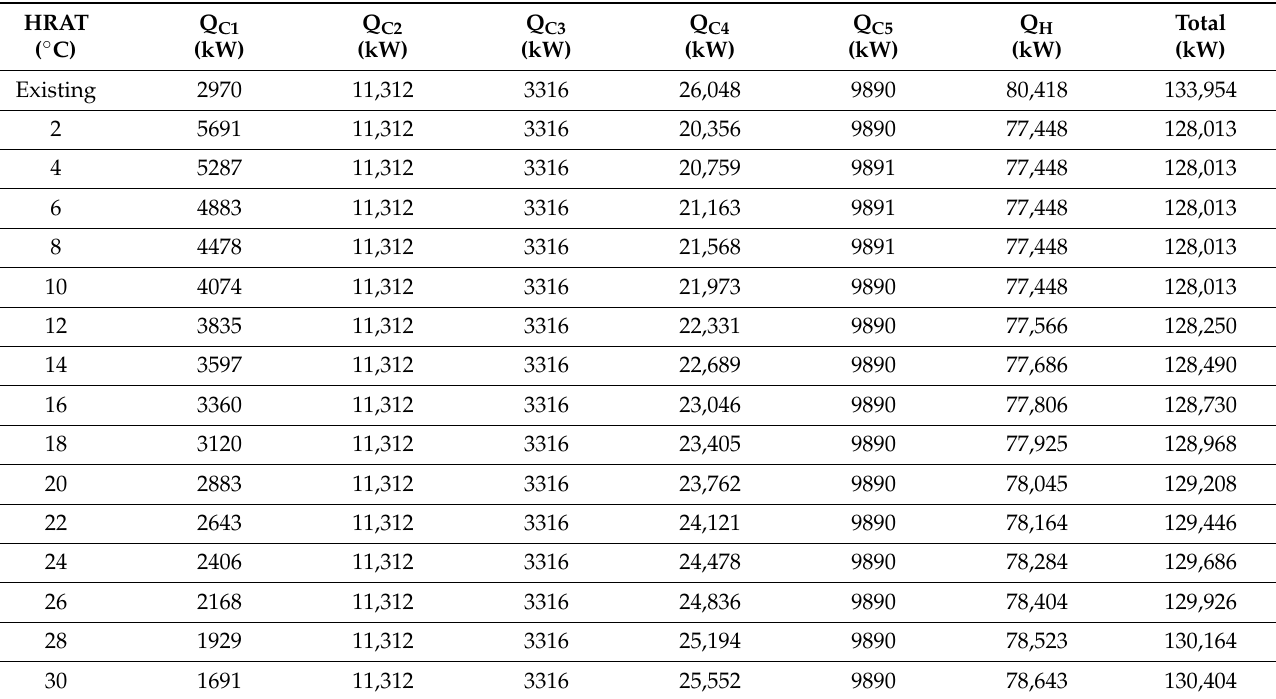
Table A8. External energy consumption at different HRAT values for option (3).